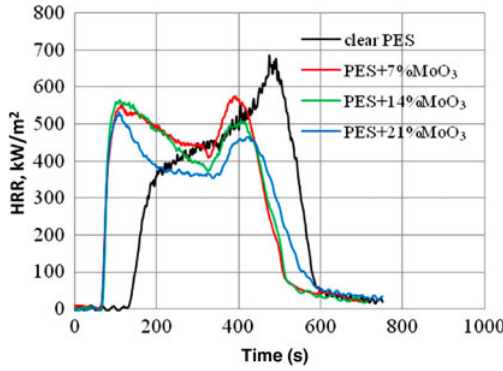
Fig. 4. Heat release rate for polyester material unmodified and modified with MoO 3 at the heat flux density of 50 kW/m 2 on piloted ignition